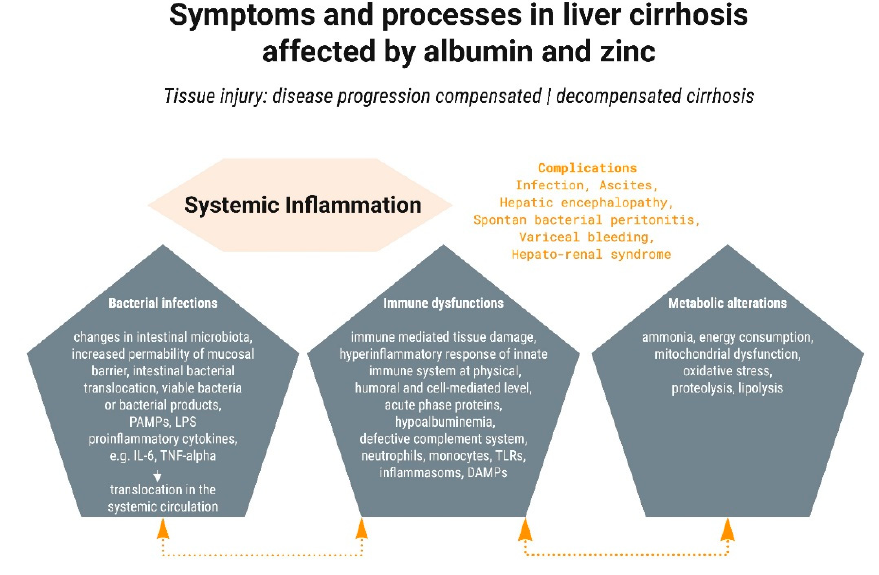
Figure 3. Schematic presentation of the influence of albumin and zinc on the pathogenesis of liver cirrhosis. Arrows indicate the relations and the interactions between bacterial infections, immune dysfunctions, and metabolic alterations.